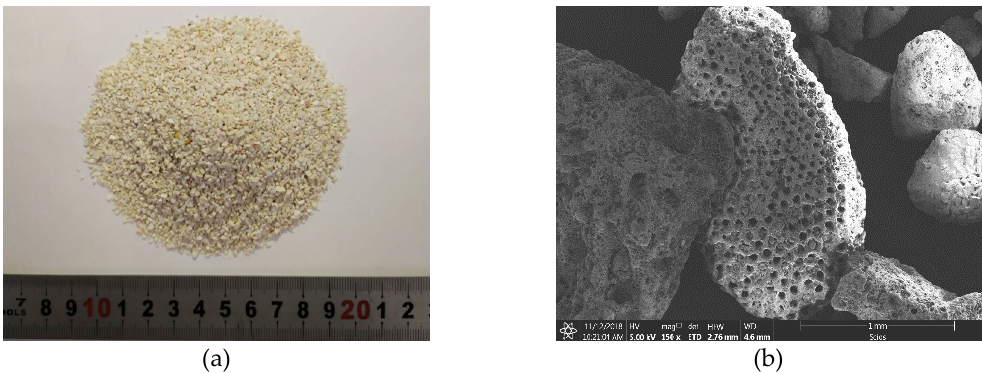
Figure 1. Typical sample of the coral sand: ( a ) coral sand sample; ( b ) microparticle shape of coral sand.